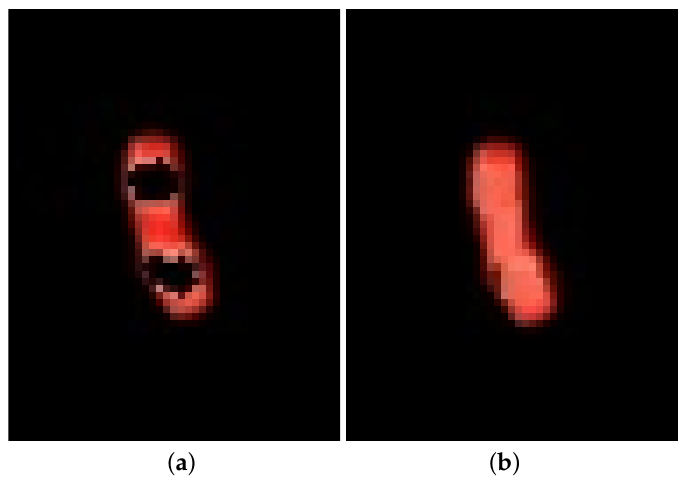
Figure 6. Interesting point enhancement: ( a ) thresholding result; ( b ) enhancement result.